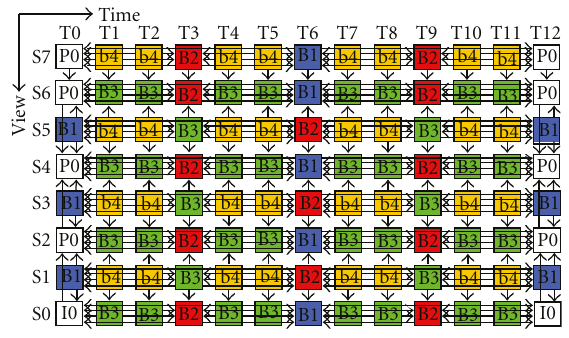
Figure 4: MVC-HBP prediction structure.